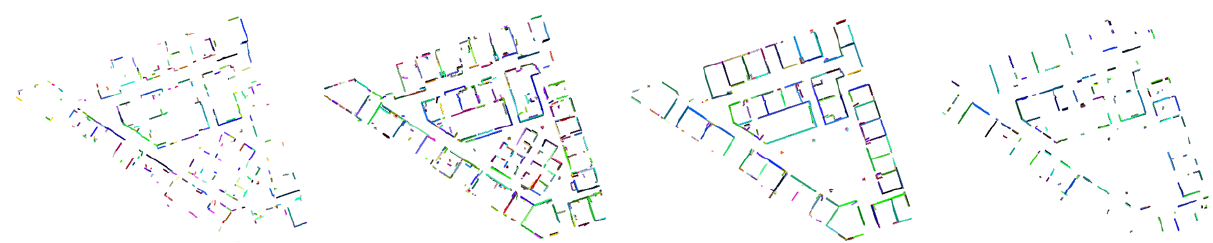
Figure 2. Comparison of Clutter and Occlusion involvement in data in different horizontal